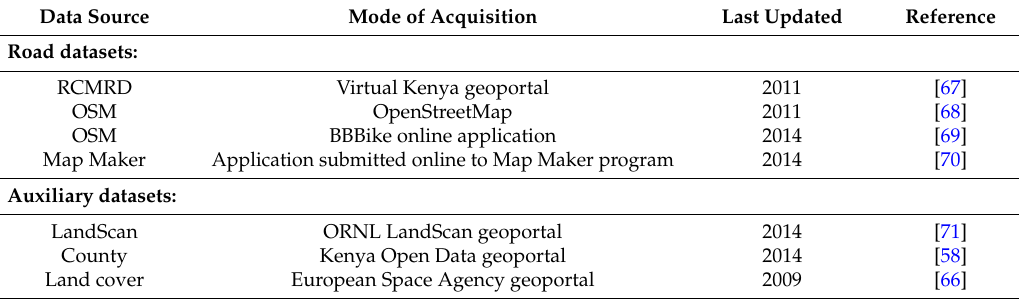
Table 1. Datasets used for this study. RCMRD, Regional Center for Mapping of Resources for Development; ORNL, Oak Ridge National Laboratory.